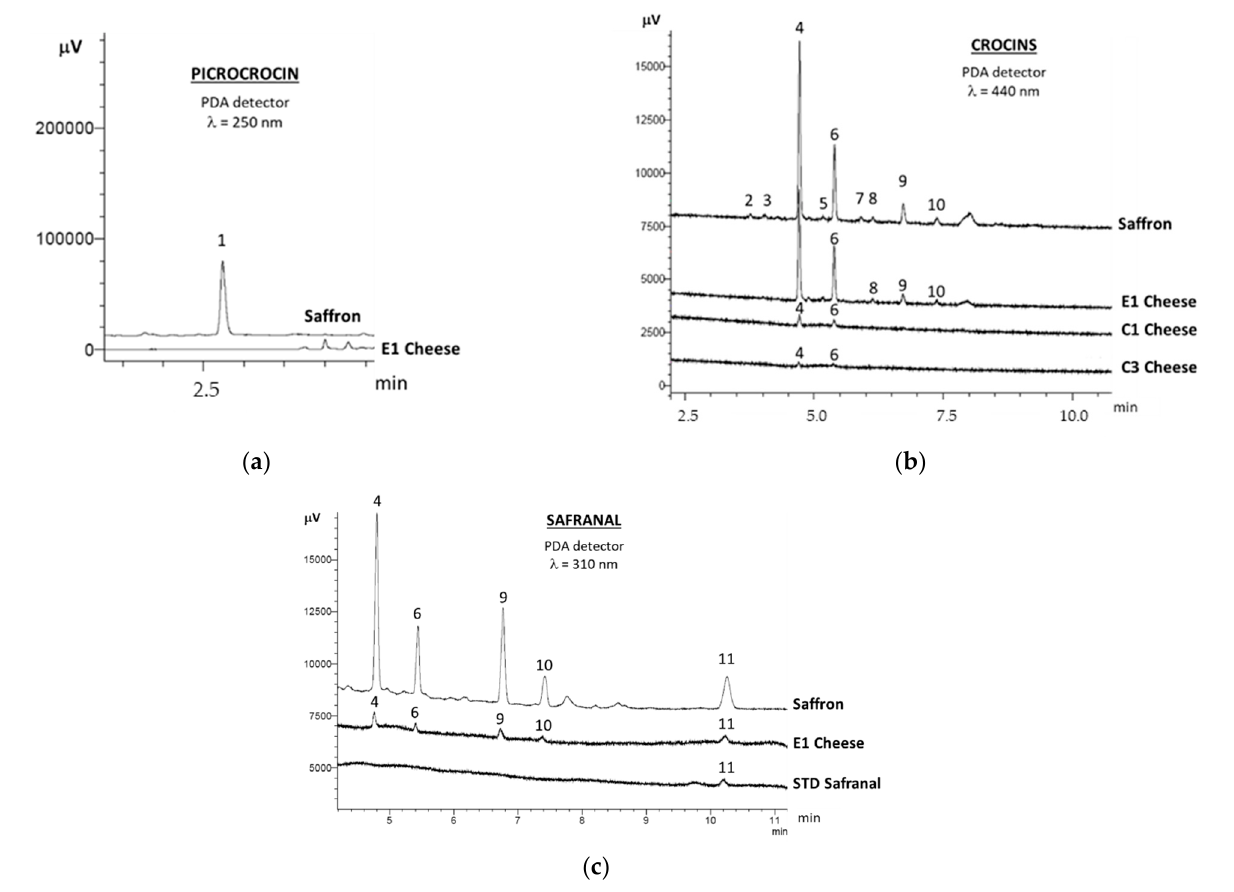
Figure 1. ( a ) UHPLC chromatograms of saffron and ewe cheese (E1) extracts detected at 250 nm; ( b ) UHPLC chromatograms of saffron, ewe (E1) and cow cheeses (C1, C3) extracts detected at 440 nm; ( c ) UHPLC chromatograms of saffron and ewe cheese (E1) extracts, together with a safranal standard (32 μ g/L), detected at 310 nm: picrocrocin (peak 1); trans ‐ crocins (peaks 2, 3, 5, 7, 8); trans ‐ 4 ‐ GG (peak 4); trans ‐ 3 ‐ gG (peak 6); cis ‐ crocins (peaks 9, 10); safranal (peak 11).